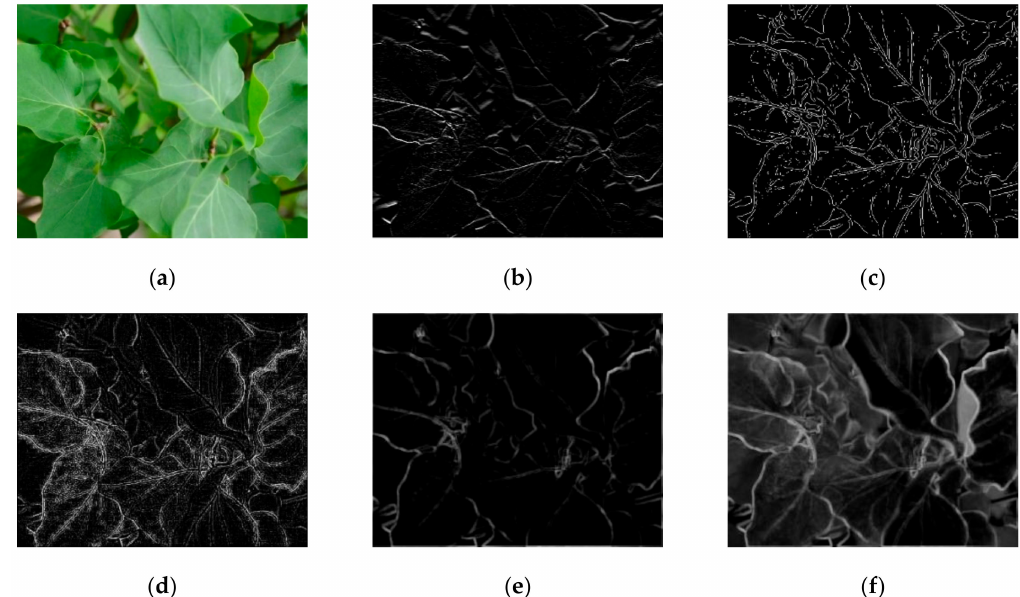
Figure 1. Comparison of di ff erent edges selection method: ( a ) Original image, ( b ) first-order gradients of image, ( c ) edges extracted by Canny operator, ( d ) Laplace gradients, ( e ) local edges of gray value image obtained by the proposed method, ( f ) local edges of color image obtained by the proposed method.